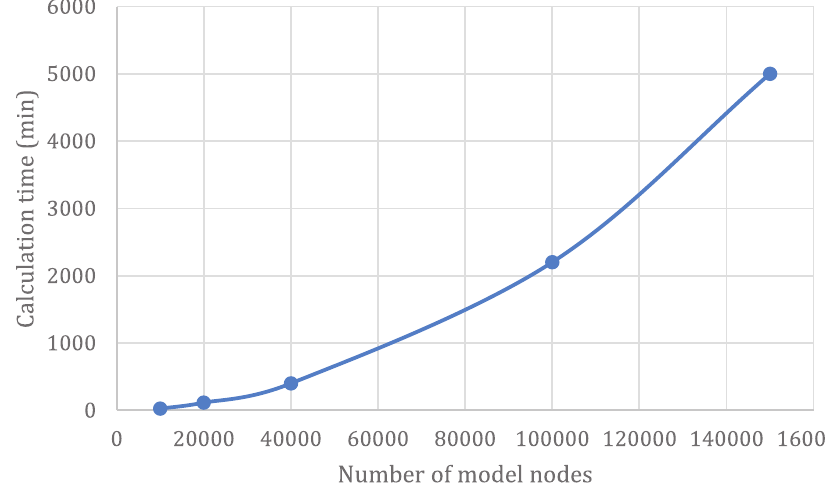
Figure 4. The dependence of the calculation time on the number of nodes in the EEN